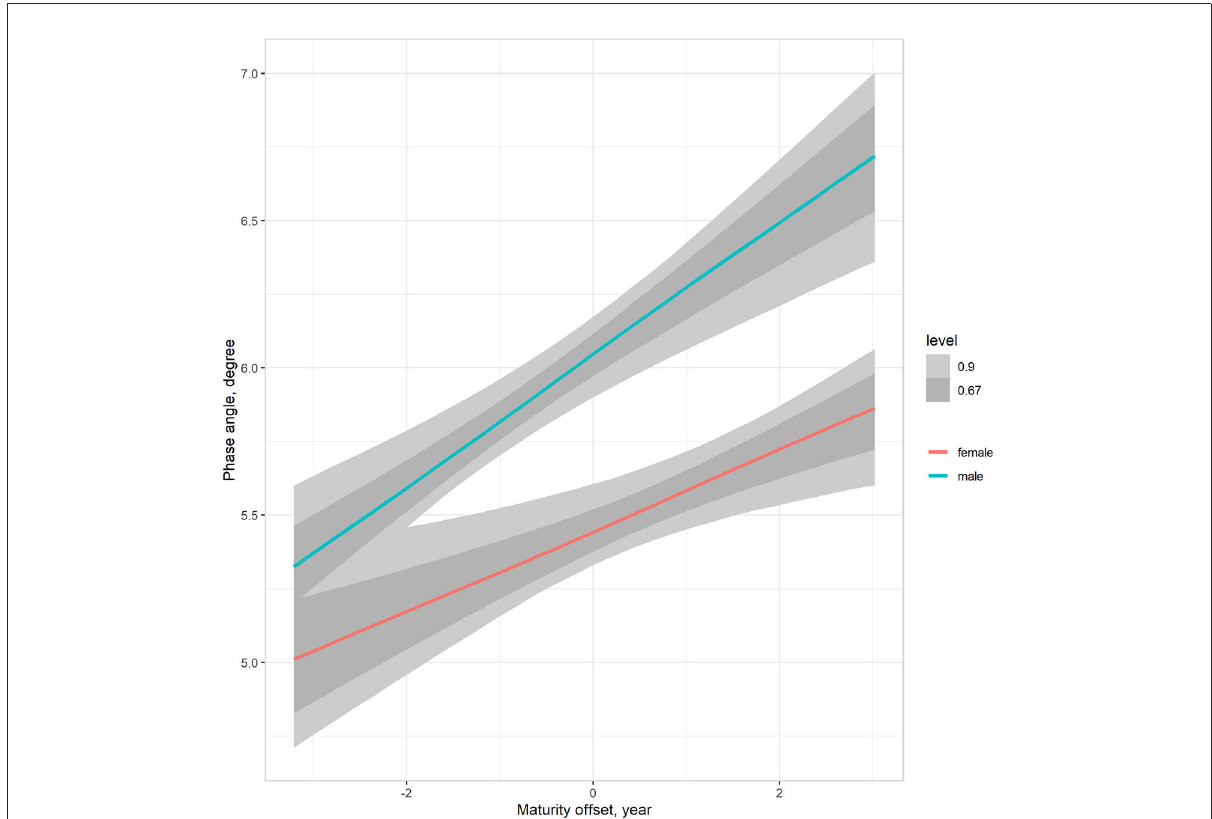
FIGURE3 Posterior estimations (67 and 90% CIs) of the association of the phase angle with estimated time before and after the age at PHV (maturity offset) by